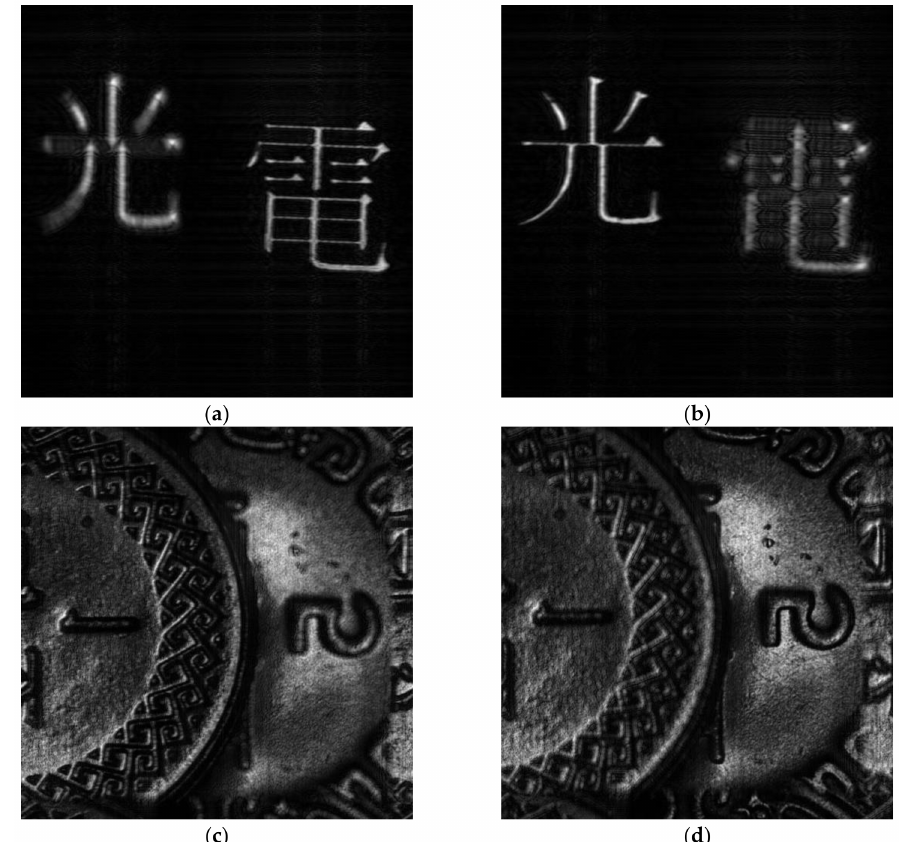
Figure 5. ( a ) Reconstructed image of hologram “A” at 0.021 m; ( b ) Reconstructed image of hologram “A” at 0.024 m; ( c ) Reconstructed image of hologram “B” at 0.0197 m; ( d ) Reconstructed image of hologram “B” at 0.027